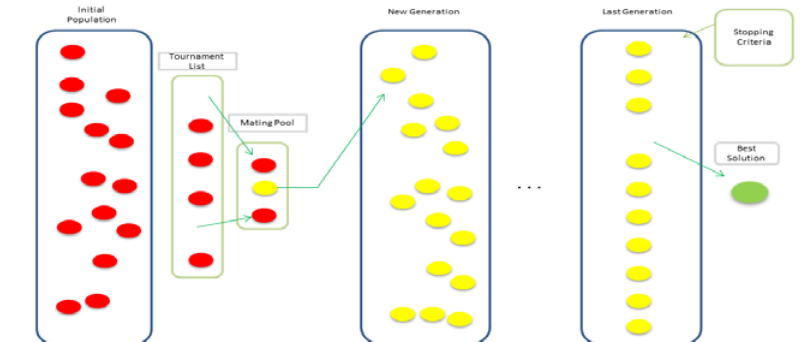
Fig. 3. A scheme of GA performance for improving the characteristics of population members over